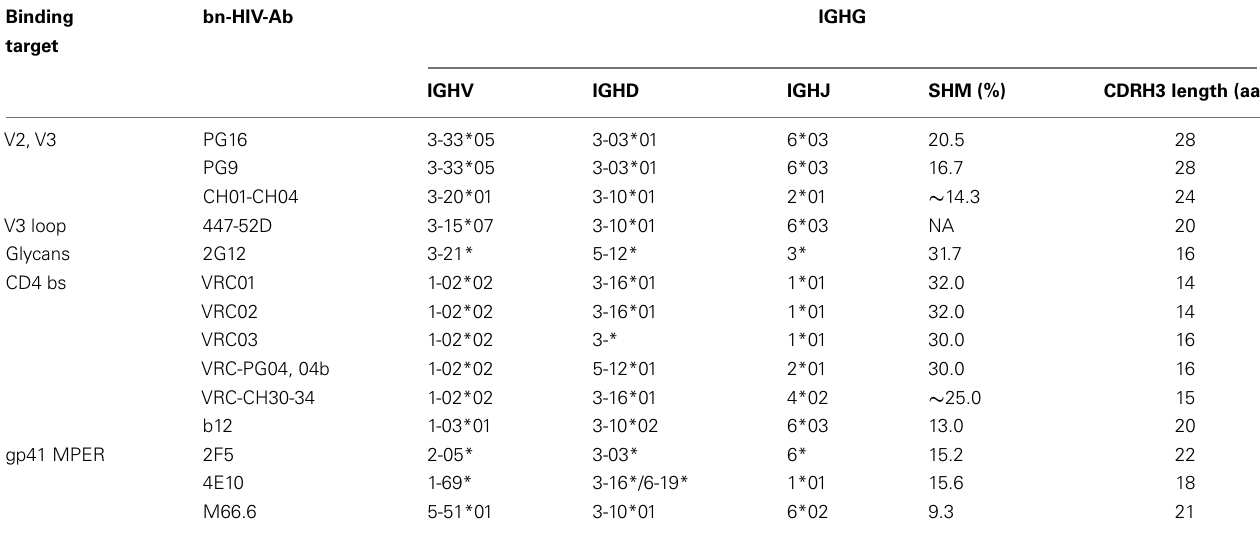
Table 3 | Characteristics of IGHG in bn-HIV-Abs. Binding